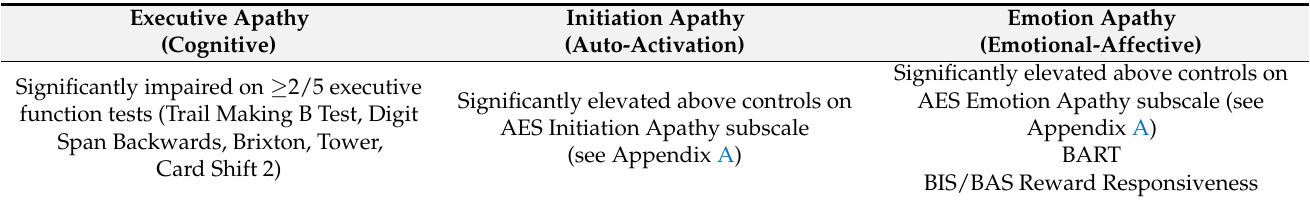
Table 2. Apathy dimensions: Method of classification based on Levy and Dubois